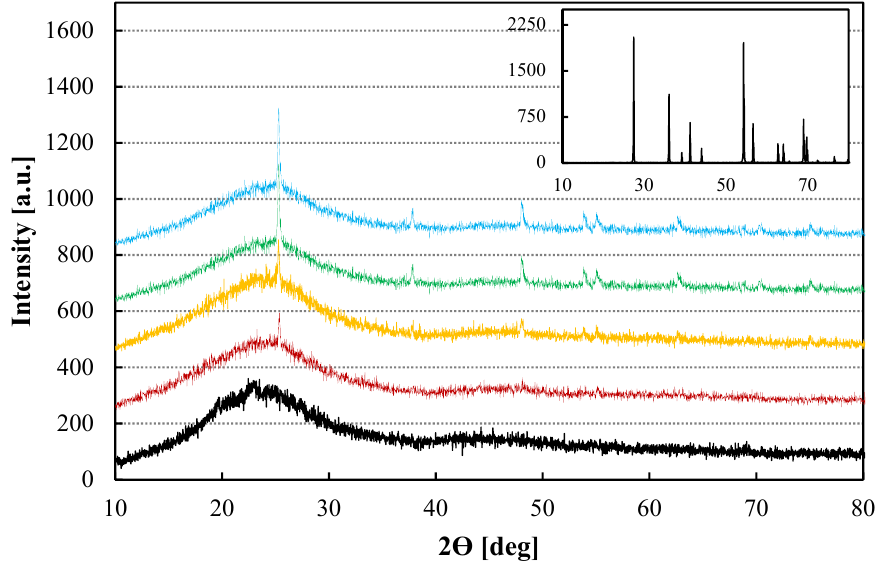
Figure 1. XRD data for the pristine and TiO 2 -PBI composite membranes. Inset: XRD of pure TiO 2 employed in this work. Black line: Std-PBI; Red line: 0.5 wt% TiO 2 -PBI; Yellow line: 1.0 wt% TiO 2 -PBI; Green line: 2.0 wt% TiO 2 -PBI; Blue line: 3.0 wt% TiO 2 -PBI.